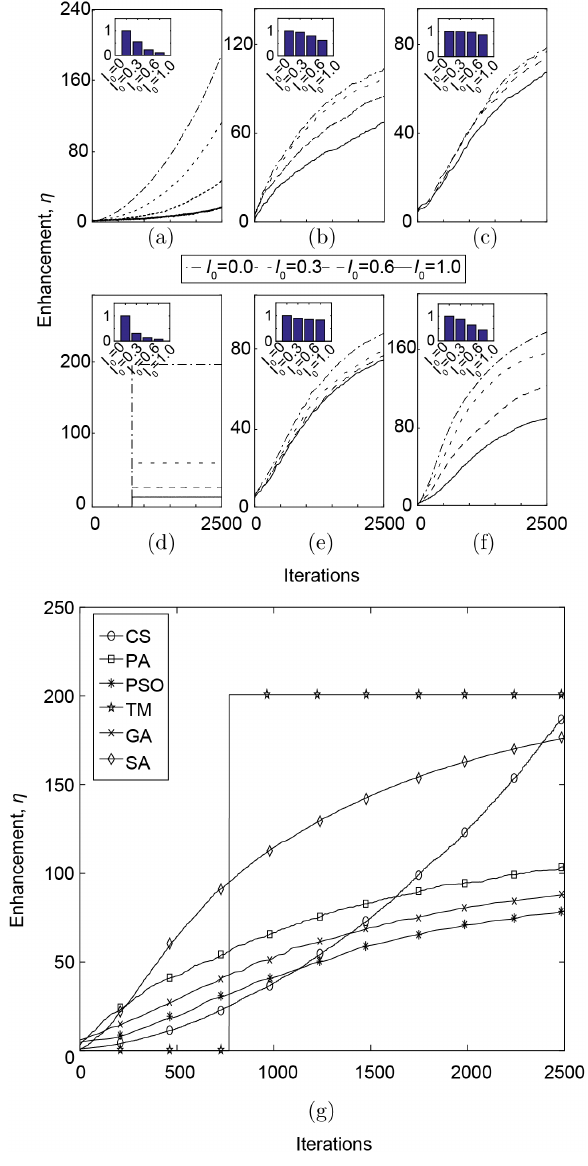
Fig. 1. Performance of the (a) Continuous sequential, (b) Partitioning algorithm, (c) Particle swarm optimization, (d) Transmission matrix method, (e) Genetic algorithm, and (f) Simulated annealing for N ¼ 256 under di®erent noise condi- tions comparing the enhancement of the focus to the number of measurements with varying noise levels. A Gaussian noise at 30%, 60% and 100% of the initial average intensity h I 0 i was added for each algorithm. (g) Performance of the algorithms in terms of e±ciency has been compared without any noise added. The curves are averaged over 20 runs. The area under the curve fordi®erent noise level is shown in the insets of each ¯gure (a) – (f).